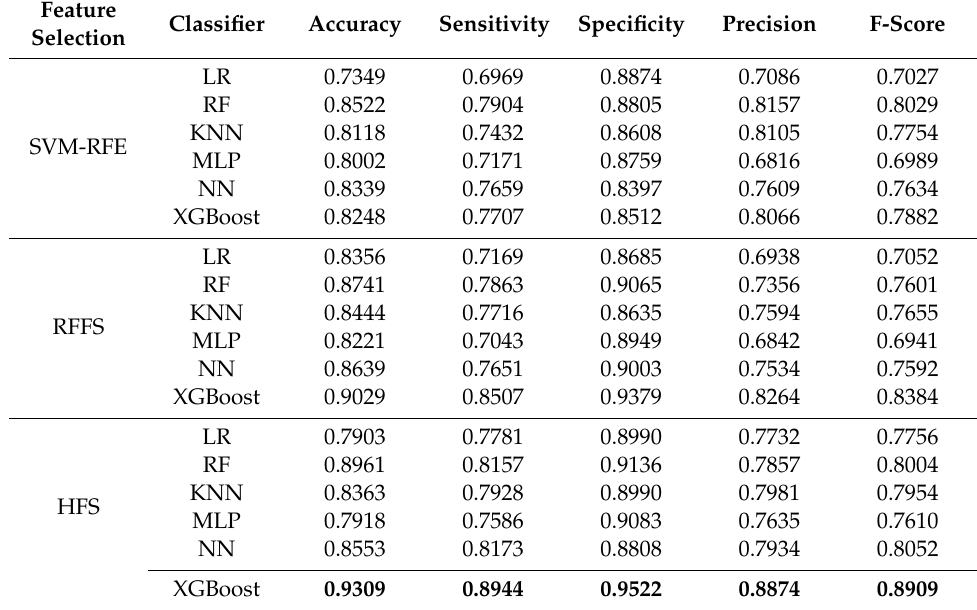
Table 3. Evaluation results of the prediction models in the National Health and Nutrition Examination Survey dataset.